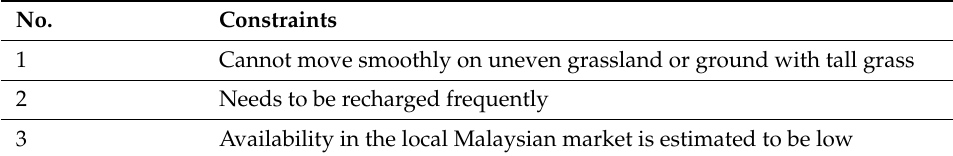
Table 1. List of identified constraints of autonomous robotic